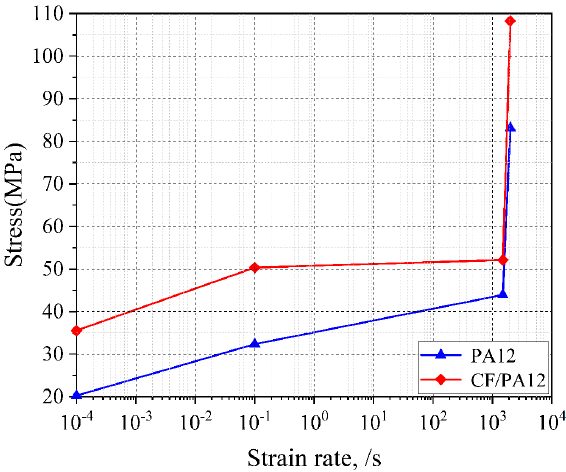
Figure 6. Effect of strain rate on the compressive mechanical properties of PA12 and CF/PA12 sam- ples.